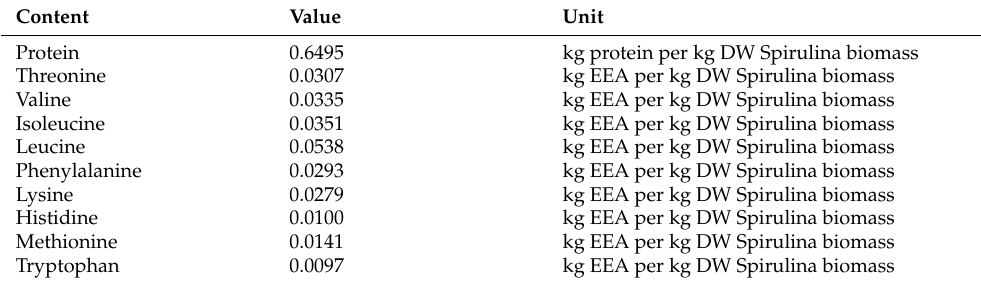
Table 1. Protein and EAAs content of Spirulina biomass DW produced in Hellisheidi PU. Content